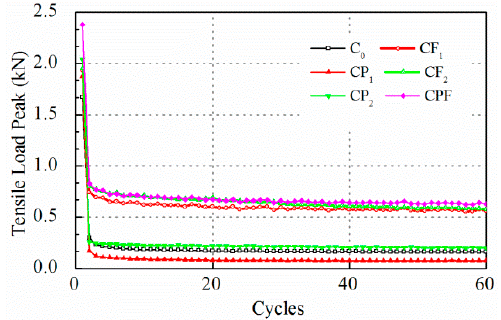
Figure 7. Tensile load peak at 0.2 mm crack opening.